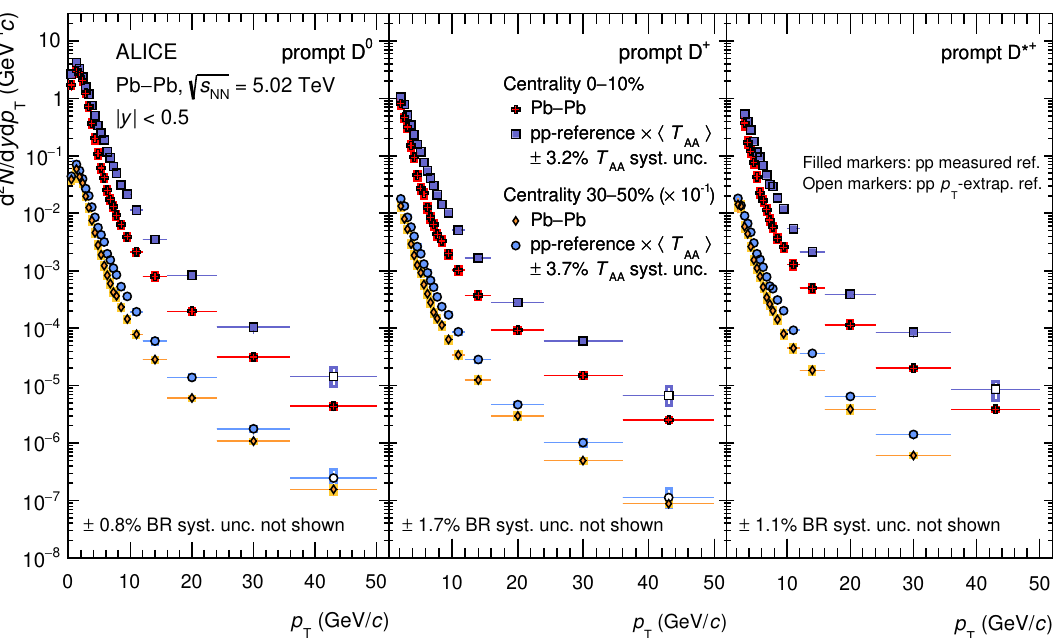
Figure 4 . Transverse momentum distributions d 2 N/ d y d p T of prompt D 0 (left), D + (middle), and D ∗ + (right) mesons in the 0–10% (cross) and 30–50% (diamond) centrality classes in Pb–Pb √ collisions at s = 5 . 02 TeV . The reference pp distributions multiplied by h T AA i are shown as well. NN Statistical uncertainties (bars) and systematic uncertainties (boxes) are shown. The uncertainties on the BRs are quoted separately and the horizontal bars represent bin widths. The spectra in the 30–50% centrality class are scaled by the factor reported in the legend for visibility. Filled and empty markers of the pp reference indicate the measured [37, 65] and p T -extrapolated values, respectively, of the p T